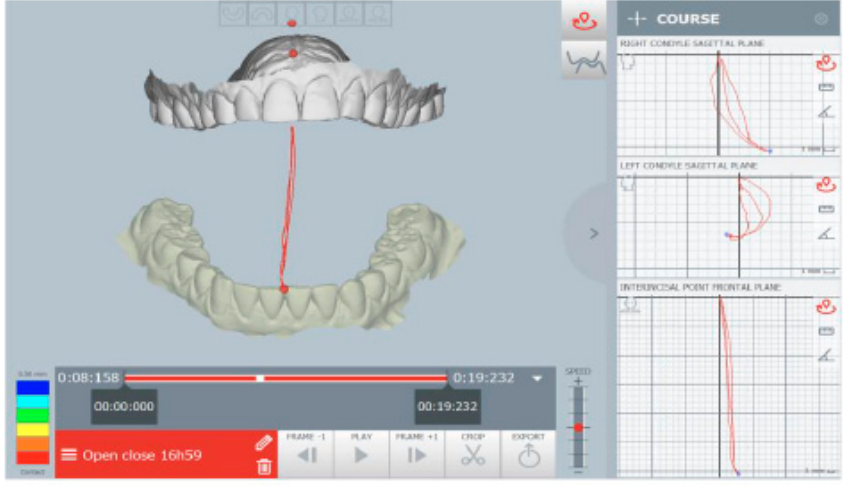
Figure 8. Opening tracing. downward by about 1 mm and re-entering the midline. The STL file of the arches in the therapeutic position highlights the gap between the dental arches (Figure 9).